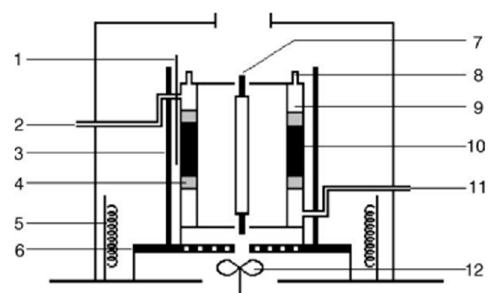
Figure 10. Another reactor design for photocatalytic methane reforming: (1) thermocouple, (2) gas outlet, (3) aluminum foil, (4) sieve plate, (5) heater, (6) graphite plate, (7) mercury lamp, (8) catalyst inlet, (9) quartz reactor, (10) catalyst bed, (11) gas inlet, and (12) fan [32]. Reprinted from [33], with permission from Elsevier.